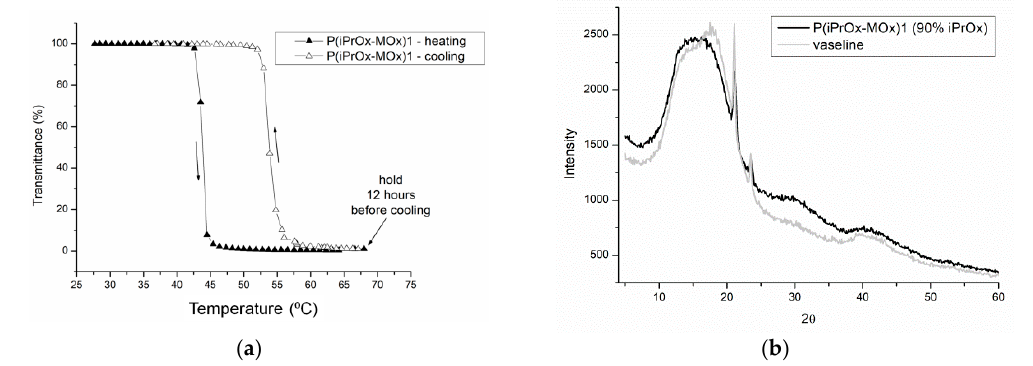
Figure 4. ( a ) Transmittance-temperature dependence during heating (filled triangles) and cooling (empty triangles) of 5 g/L aqueous solutions of P(iPrOx-MOx)1 (solution kept for 12 h at 70 °C